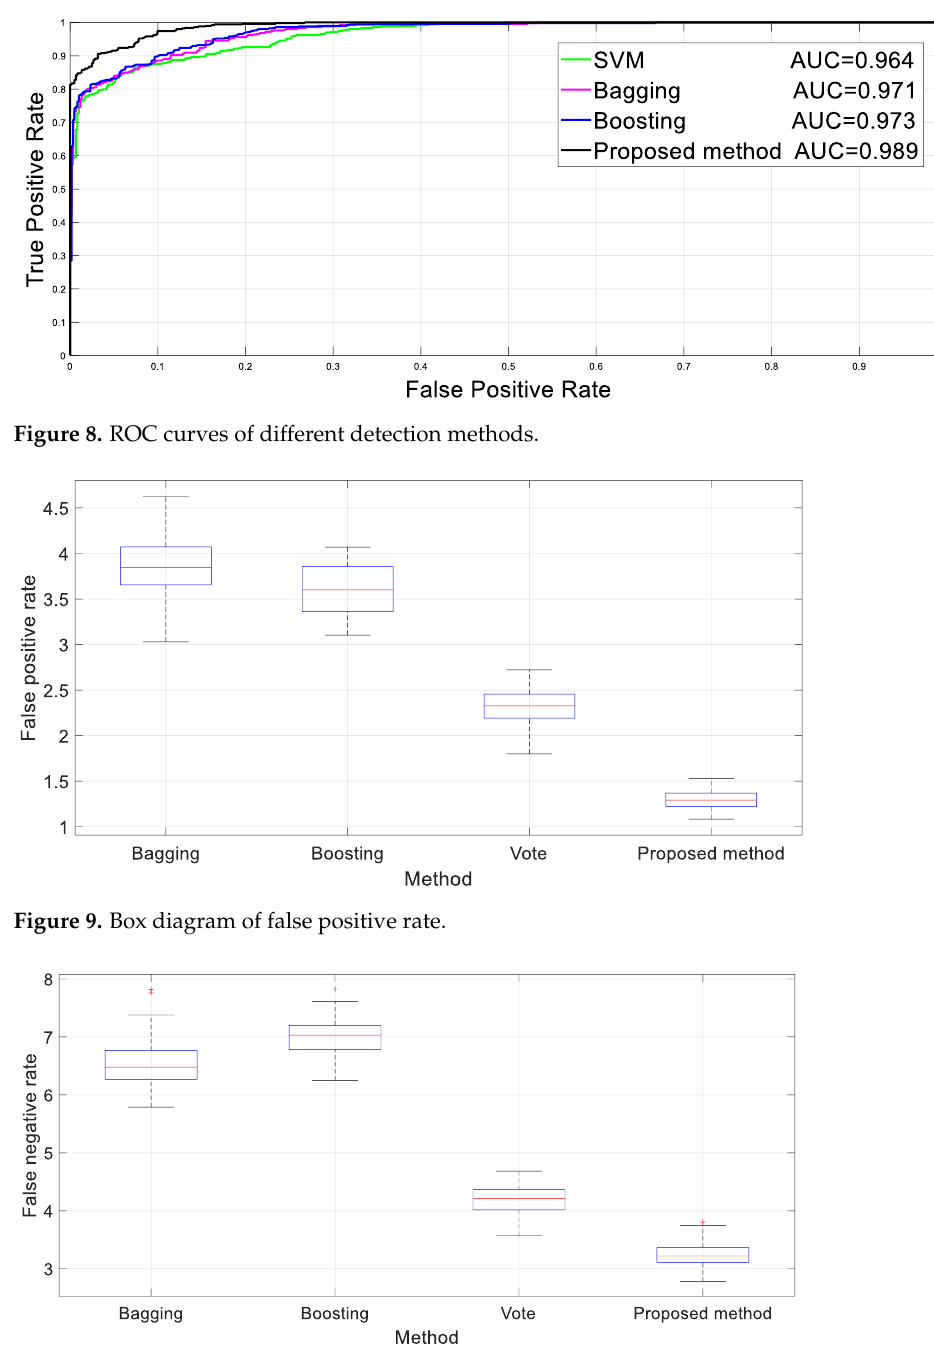
Figure 11. Box diagram of detection accuracy. The horizontal line in the box diagram represents the statistical median, the height of the box represents the distribution interval, and ‘+’ stands for abnormal value in different methods. From the experimental results, we can clearly see that the height of the proposed method box is the lowest among the three statistics, which shows that the method pro- posed in this paper is very stable. Compared with bagging and boosting, the vote method can also achieve better stability, which also reflects that the heterogeneous integration